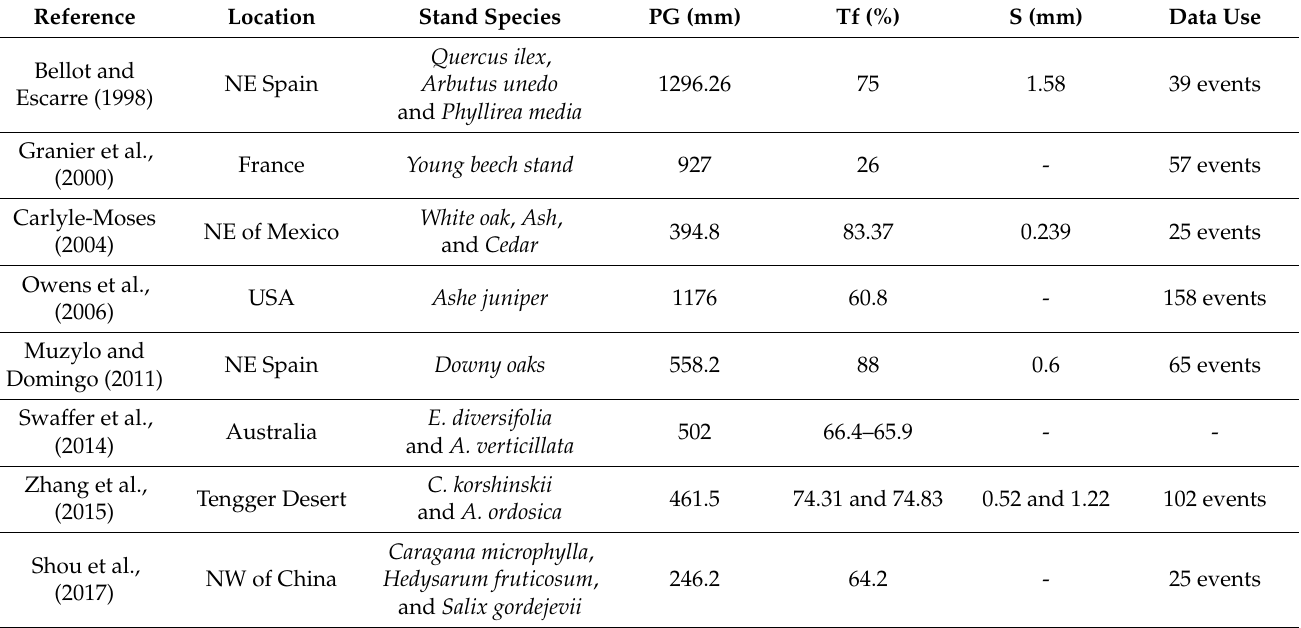
Table 4. Rainfall amount (PG), throughfall amount (Tf), and rainfall threshold (S) in different tree